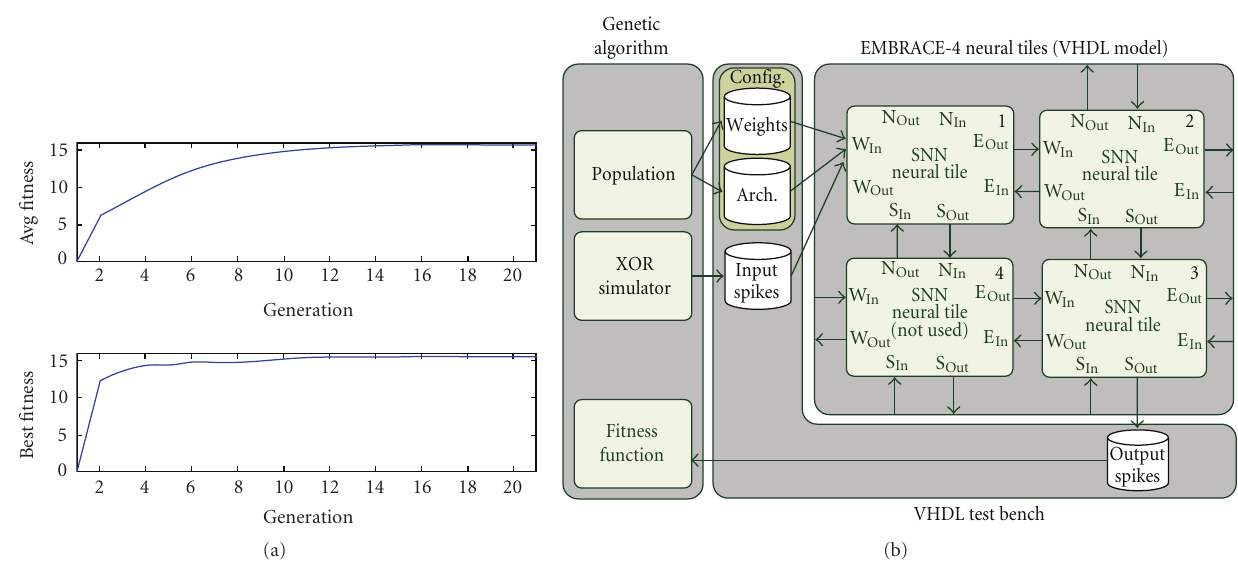
Figure 8: Evaluation setup of SNN-based XOR function (realised on 2 × 2